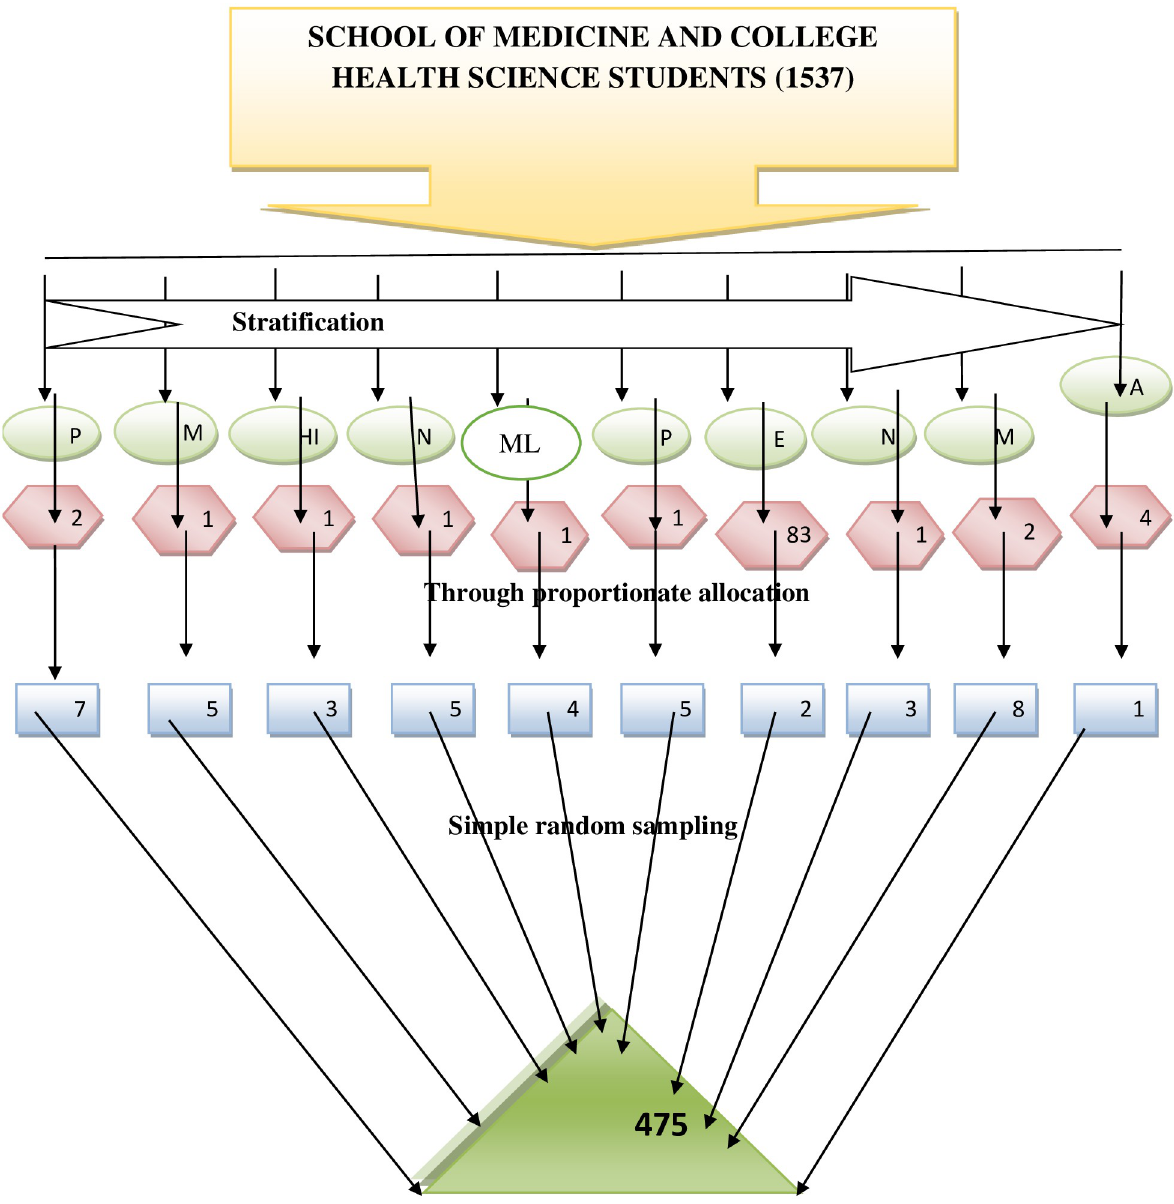
Fig 1. Schematic presentation of sampling technique for mental distress and associated factors among SMCHS students at DMU, Northwest Ethiopia, 2021. P = Pharmacy, M = Medicine, HI = health informatics, N = nursing, ML = Medical laboratory, P = Public health, E = enviromental health, N = nutrition, M = Midwifery, A =